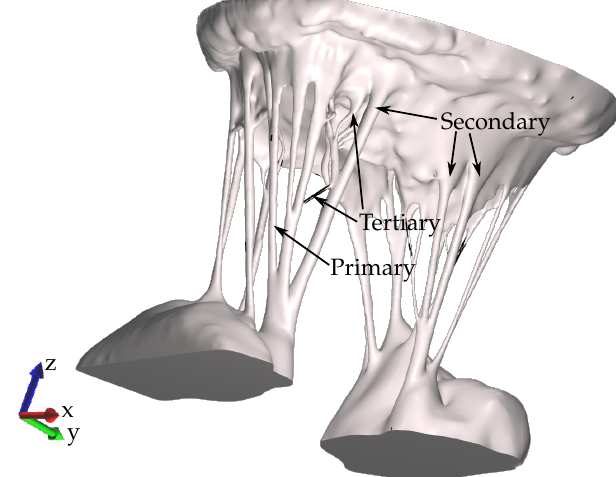
Figure 2. The detailed MV model extracted from DICOM µ CT images with all chords